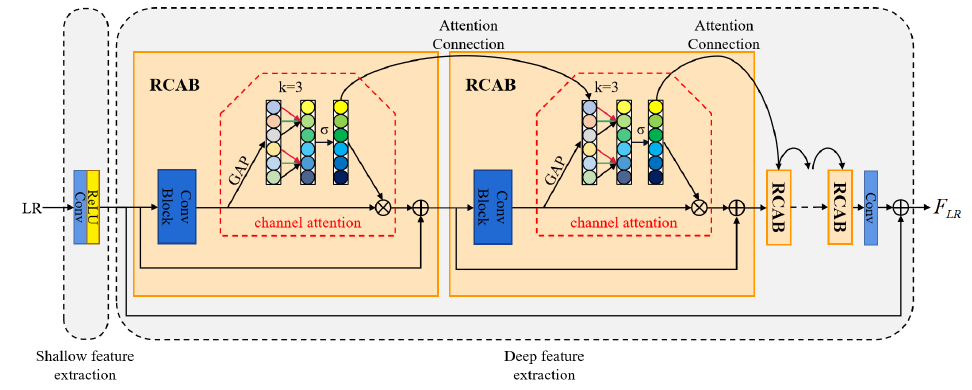
Figure 2. An illustration of the deep channel attention connection network (DCACN). The ConvBlock in RCAB consists of two convolutional layers and a ReLU activation layer placed between them. For a given feature map F ∈ R H × W × C produced by a convolutional block, we adopt the global averaging pooling (GAP) operation to generate the channel statistics as E ∈ R 1 × 1 × C